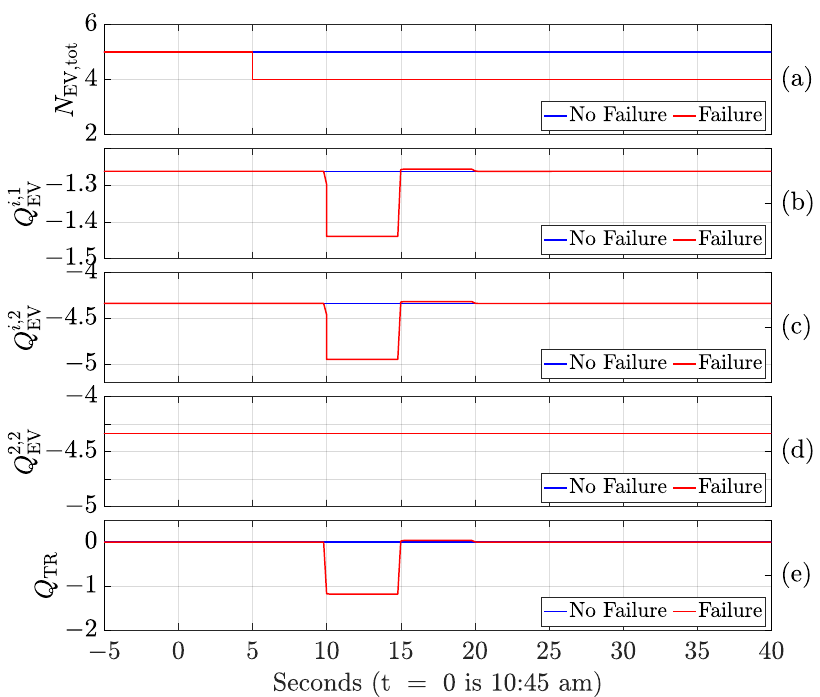
Figure 19. System response without and with communication failure case 3, ( a ) number of EVs present; ( b ) Q supplied by an online EV at Level 1 in kVAr; ( c ) Q supplied by an online EV at Level 2 in kVAr; ( d ) Q supplied by EV-2 at Level 2 in kVAr; ( e ) transformer reactive power in